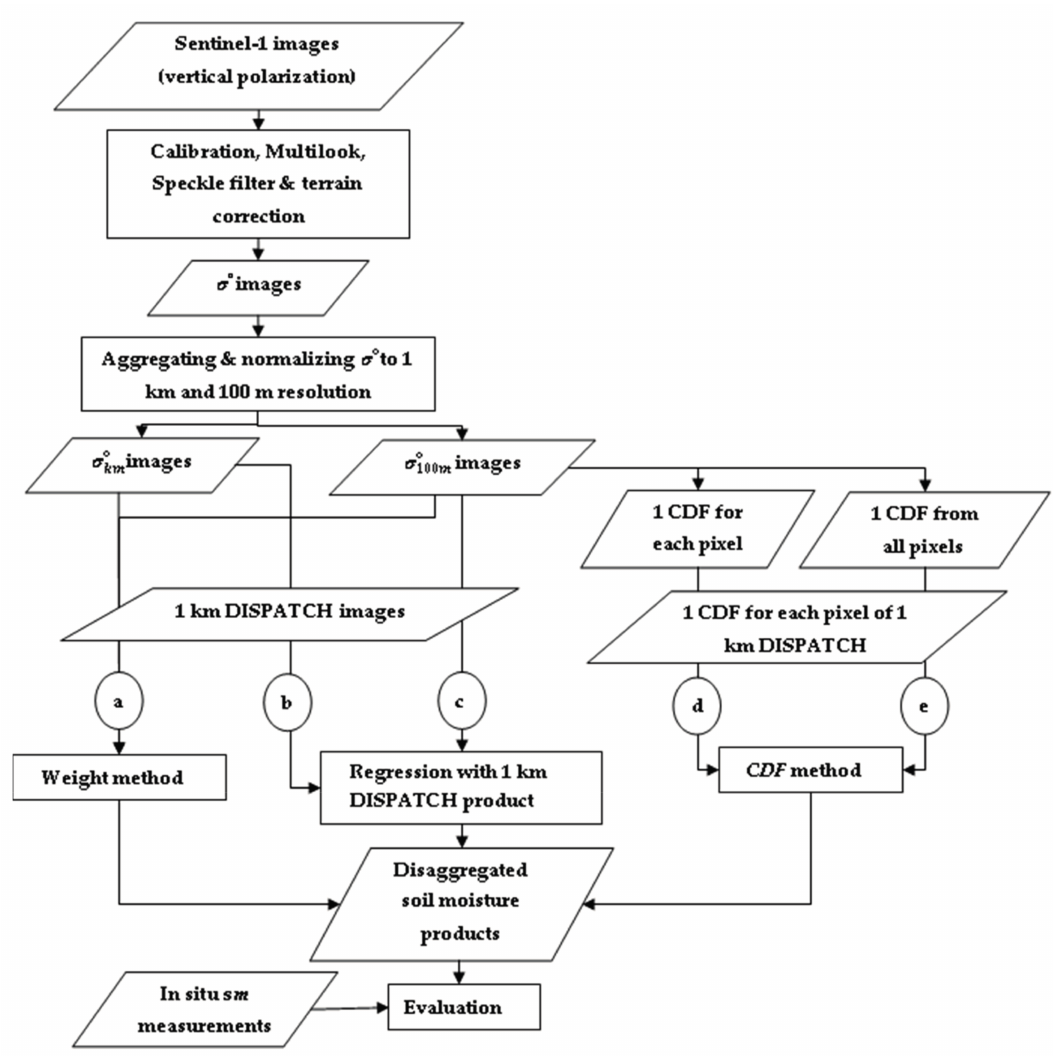
Figure 2. Disaggregating the 1 km DISPATCH product to 100 m resolution with methods referred to as: ( a ) weight; ( b ) regress km ; ( c ) regress 100m ; ( d ) CDF every ; and ( e ) CDF all